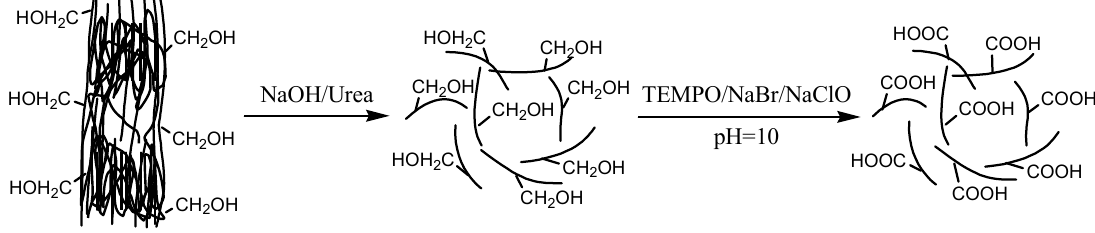
Figure 1. Preparation of NaOH/urea-treated TEMPO-oxidized cellulose using a two-step process.